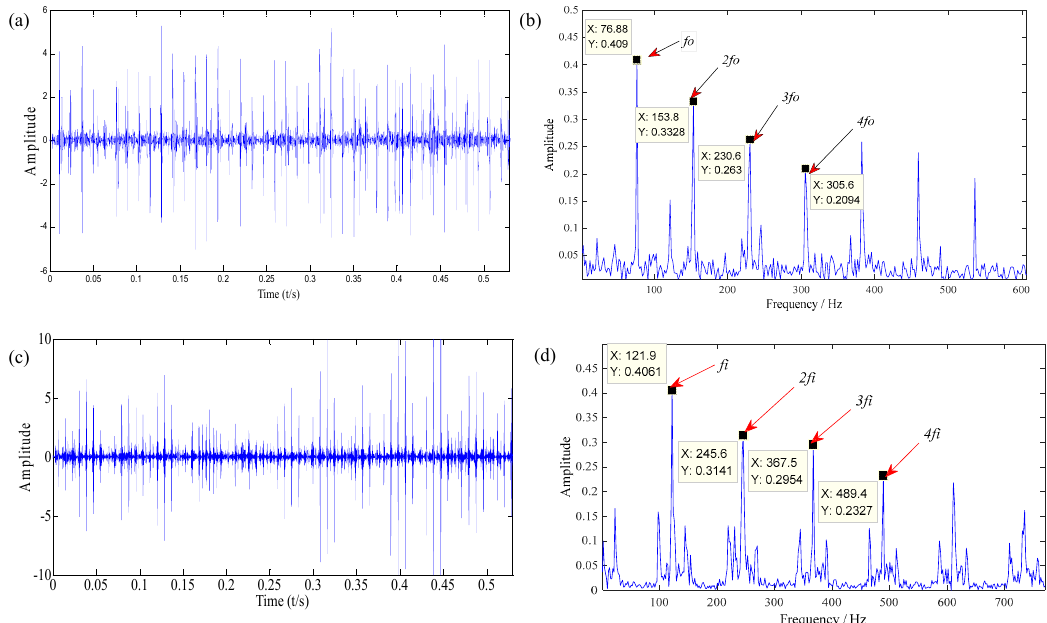
Figure 17. The analyzed results of case 2 with the proposed method: ( a ) T o = 200, low resonance component; ( b ) T o = 200, Hilbert envelope spectrum of ( a ); ( c ) T i = 125, low resonance component; ( d ) T i = 125, Hilbert envelope spectrum of (c).